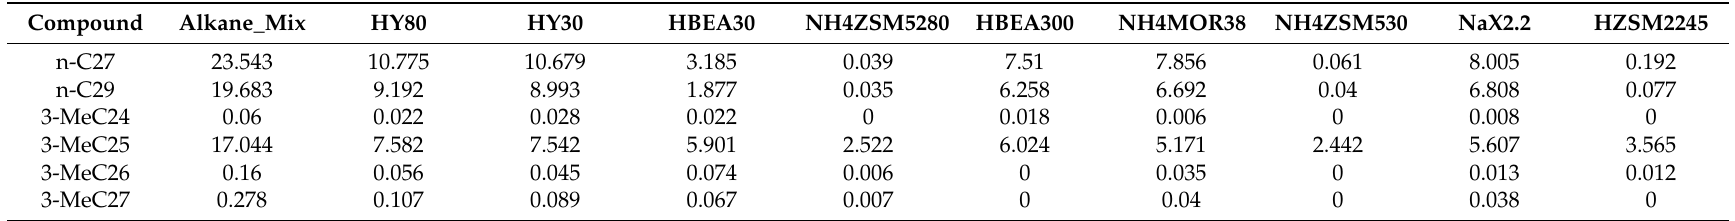
Table A2. Full dataset of compounds (in µ g/500 µ L injected sample) obtained by GC-MS analysis for the synthetic alkane mixture (alkane_mix) and the extracts of the powdered zeolite samples loaded with this